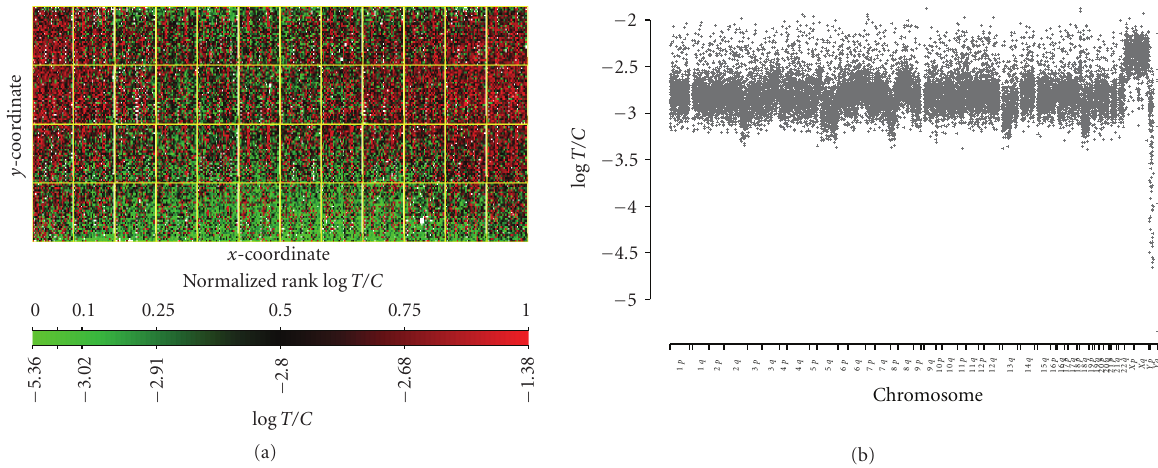
Figure 1: Raw Data: (a) Image of log T/C signal arranged in an image format corresponding to location on the microarray. (b) The aCGH log T/C data as arranged in chromosomal order. Since each BAC clone is spotted twice on the array, the genomic plot is created by averaging the two log T/C values for each BAC clone. This data corresponds to the raw normalization method where no normalization is performed.